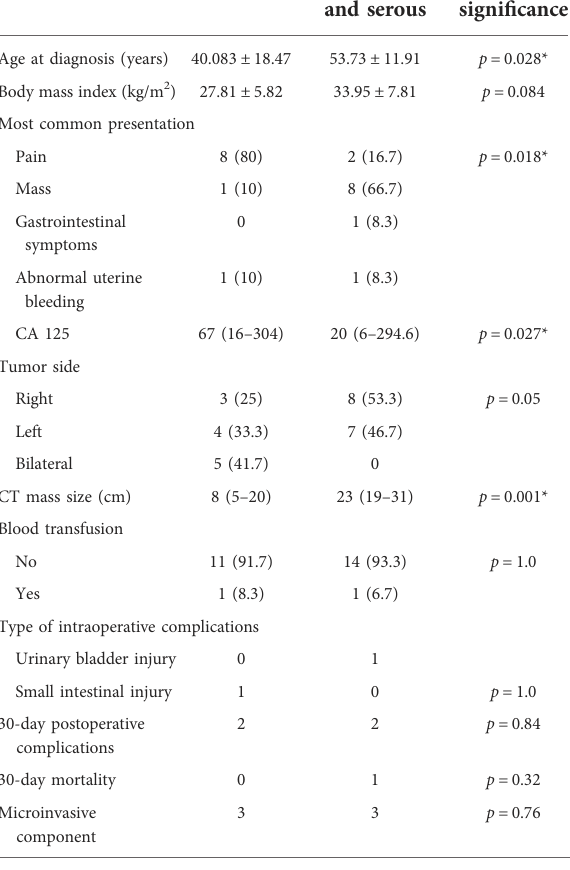
TABLE 3 Sociodemographic and clinicopathological characteristic distribution according to the pathology of the studied patients. Mucinous Seromucinous Test of and serous signi fi cance Age at diagnosis (years)